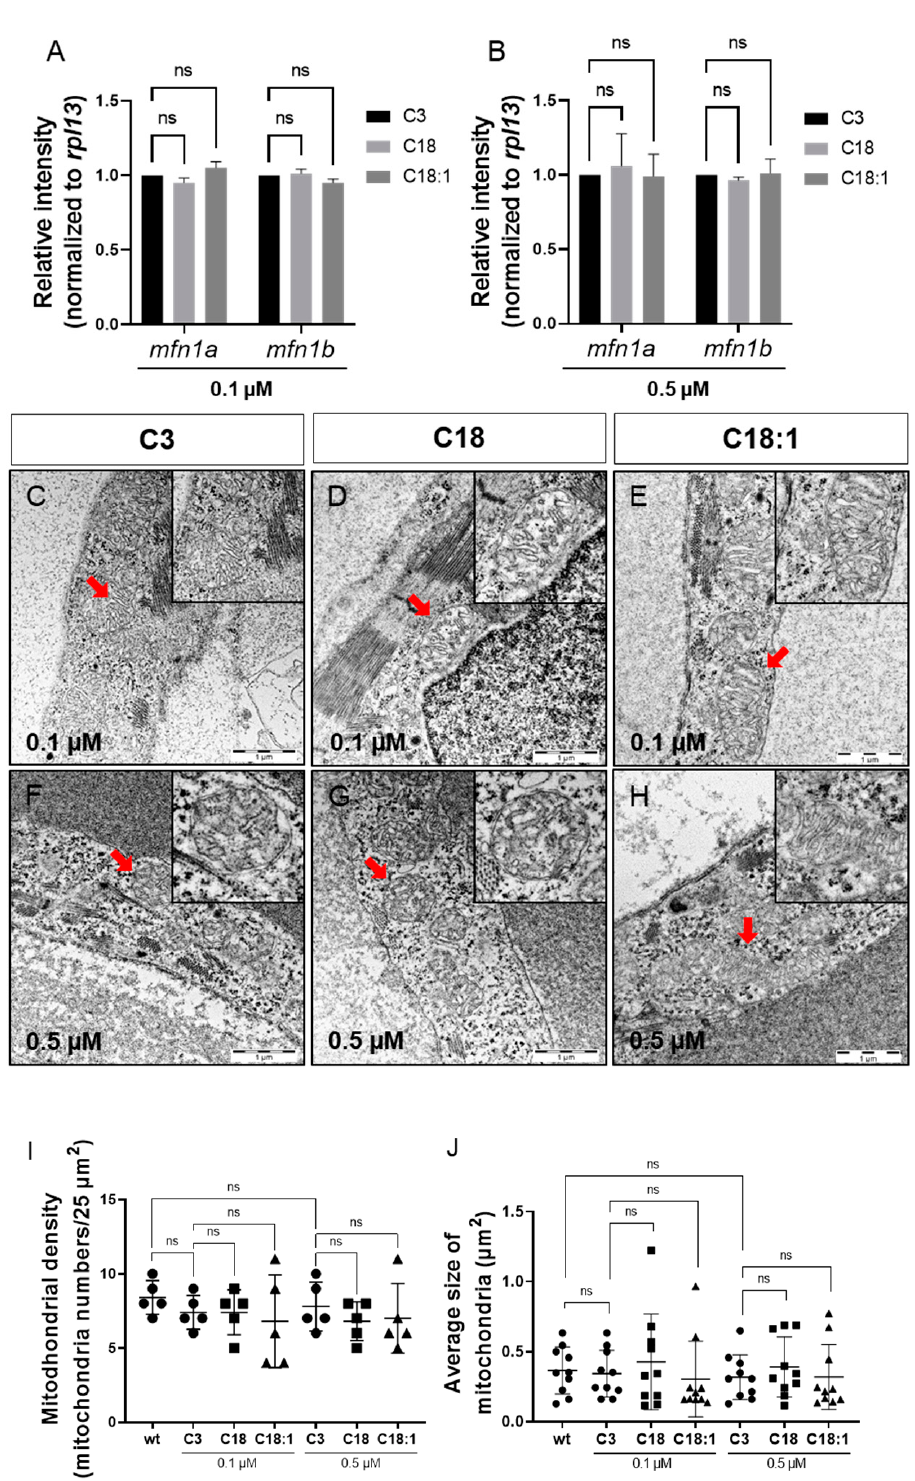
Figure 4. Sustained mitochondrial structure and distribution. ( A , B ) Quantitative real-time PCR tar- geting factors responsible for mitochondrial structure (SD, n = 3, ns: p > 0.05). ( C – H ) Mitochondria of compound-treated embryonic hearts visualized by means of electron microscopy. ( I , J ) Mitochondrial density and average size of mitochondria in EM images of embryonic zebrafish hearts treated with carnitines (SD, n = 5, 10: respectively, ns: p > 0.05). Abbreviations: ns = not significant, wt = wild-type.